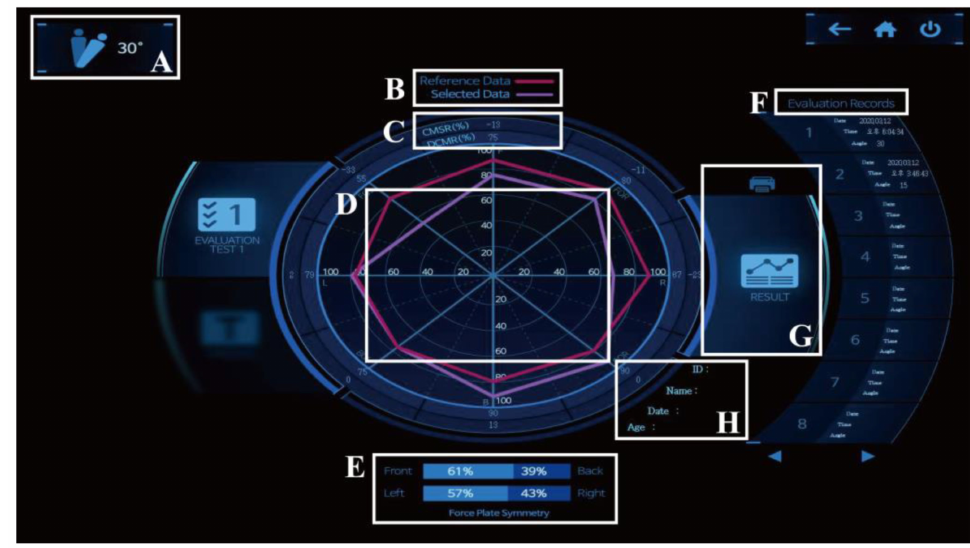
Figure 3. Display interface of a Spine Balance 3D. ( A ) angle setting, ( B ) classification color, ( C ) mea- sured value, ( D ) radial data, ( E ) force plate symmetry, ( F ) evaluation records, ( G ) output result, and ( H ) patient’s